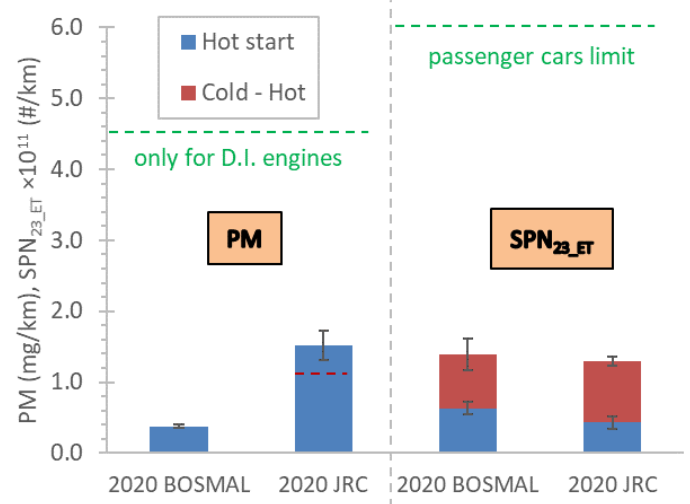
Figure 3. Particulate matter (PM) mass and solid particle number >23 nm with the evaporation tube system (SPN 23_ET ) emissions.